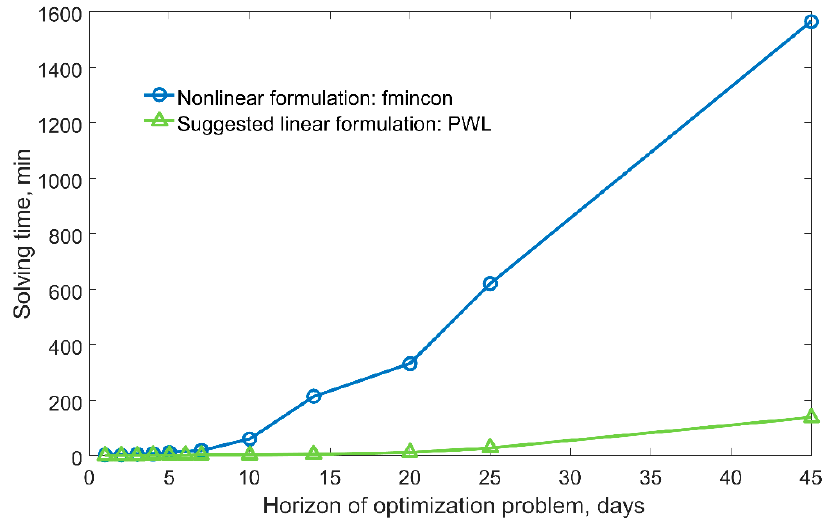
Figure 18. Computation times for the nonlinear formulation (the blue line) and for the suggested PWL formulation (the green line). Both formulations were tested for the “energy-shedding” case (SOC 0 DR = 100% and SOC t=TDR = 0%).